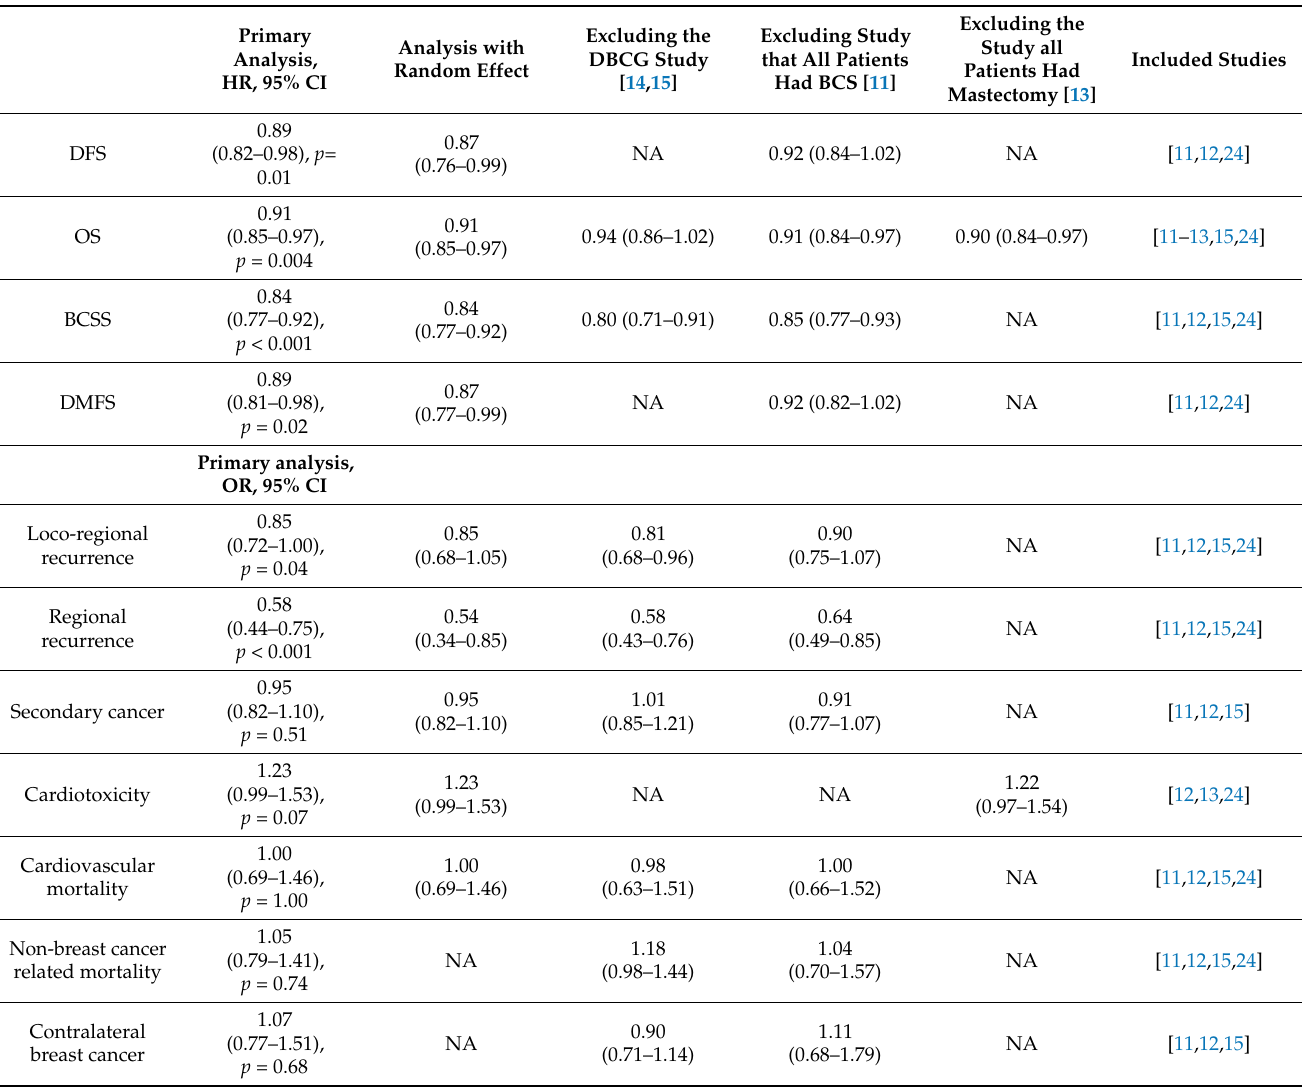
Table 3. A summary of the efficacy and toxicity results and